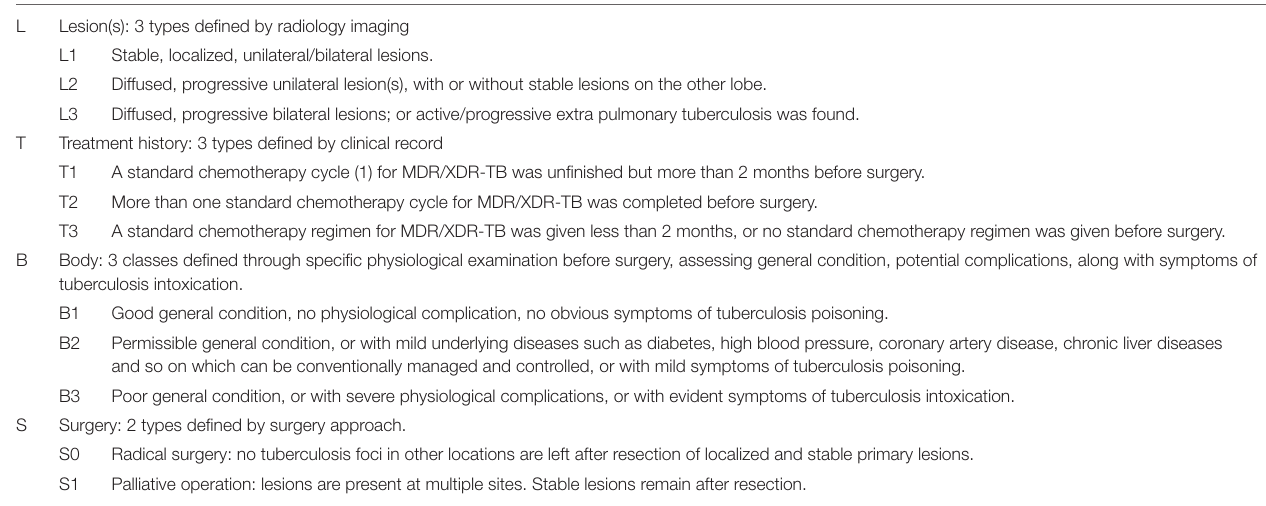
TABLE 1 | Description of LTBS Classification